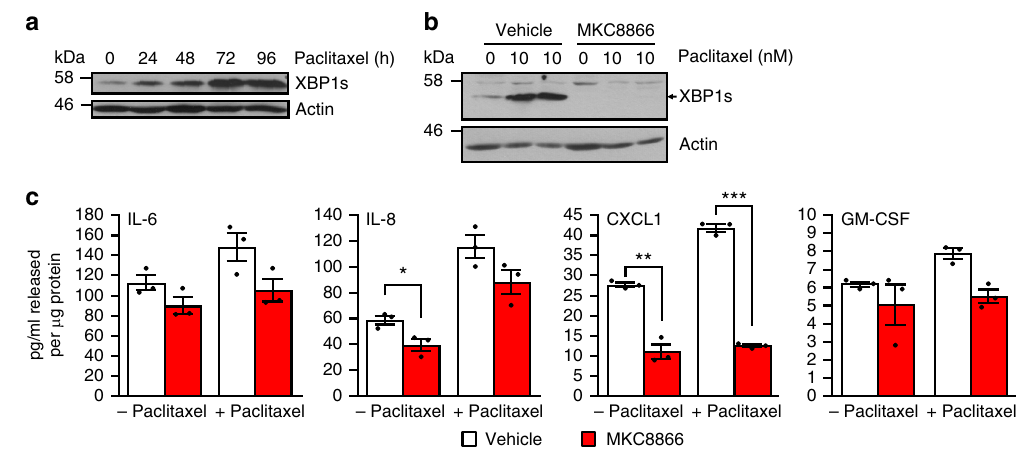
Fig. 5 Paclitaxel increases IRE1-dependent cytokine secretion. a MDA-MB-231 cells were treated with 10 nM paclitaxel for the indicated times, and cell lysates were immunoblotted for XBP1s and Actin. b MDA-MB-231 cells were treated with 10 nM paclitaxel in the presence of 20 μ M MKC8866 or vehicle (DMSO) for 72 h, cell lysates were harvested and immunoblotted for XBP1s and Actin. c MDA-MB-231 cells were treated with 10 nM paclitaxel in combination with DMSO or 20 μ M MKC8866 for 72 h in the presence of Boc-D-fmk (40 μ M). Following treatment conditioned medium was collected and analyzed by ELISA for secretion of IL-6, IL-8, CXCL1, and GM-CSF. Cells were lysed and protein quanti fi ed ( n = 3). Results shown for a and b are representative of three independent experiments. * P < 0.05, ** P < 0.01, *** P < 0.001, based on a Student ’ s t test. Error bars represent